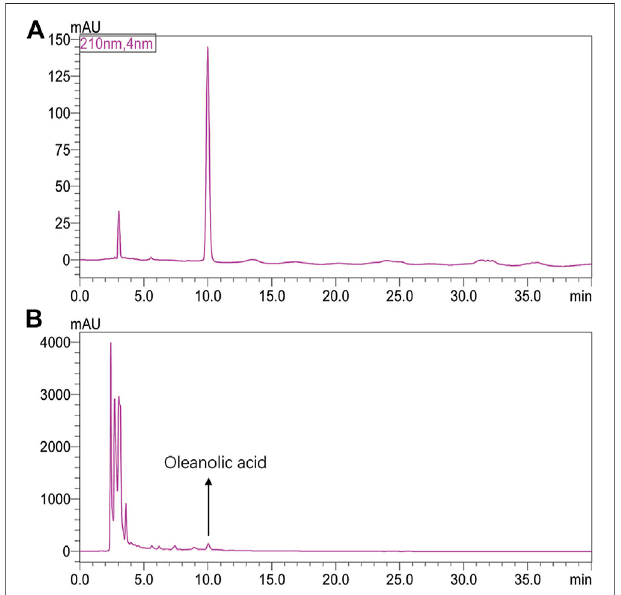
FIGURE 1 | HPLC chromatograms of the standard oleanolic acid (A) and HYQ Sample (B) .